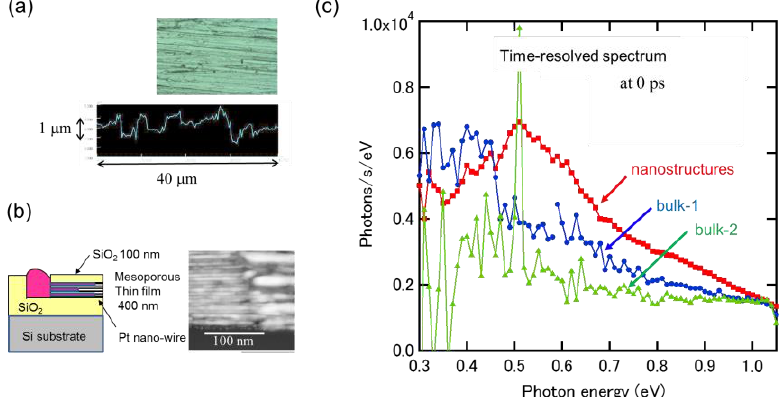
Fig. 1. (a) Surface of the Pt plate roughened by a sand-paper observed with a laser microscope. A typical cross-section of the surface is also shown. (b) Illustration of the device structure containing the Pt nano-structures grown in mesoporous silica. A TEM image of the typical wire structure is shown on the right. (c) Time-resolved luminescence spectra in Pt nano-structures and bulk Pt at 0 ps. Bulk-1 and -2 correspond to different places of the roughened